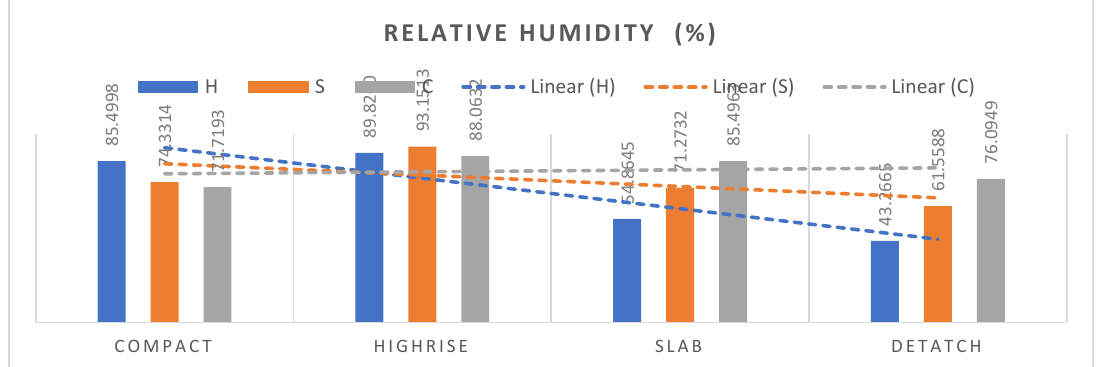
Fig. 17: Comparison of average relative humidity from simulation performed on the hottest, coldest and sultriest days of the year between four selected